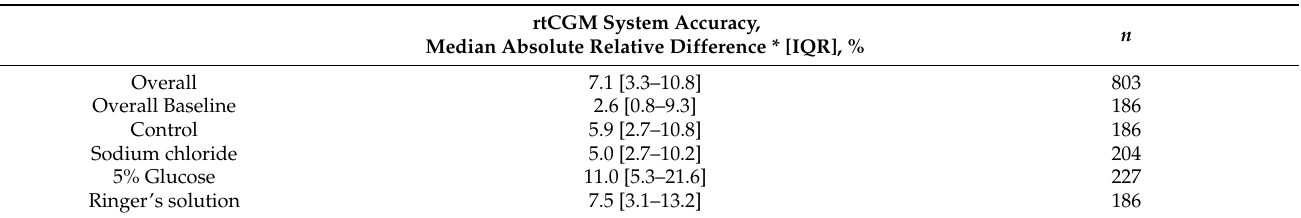
Table 1. Median absolute relative difference (MedARD) and interquartile range (IQR) between interstitial glucose and reference blood glucose for the four trial visits.